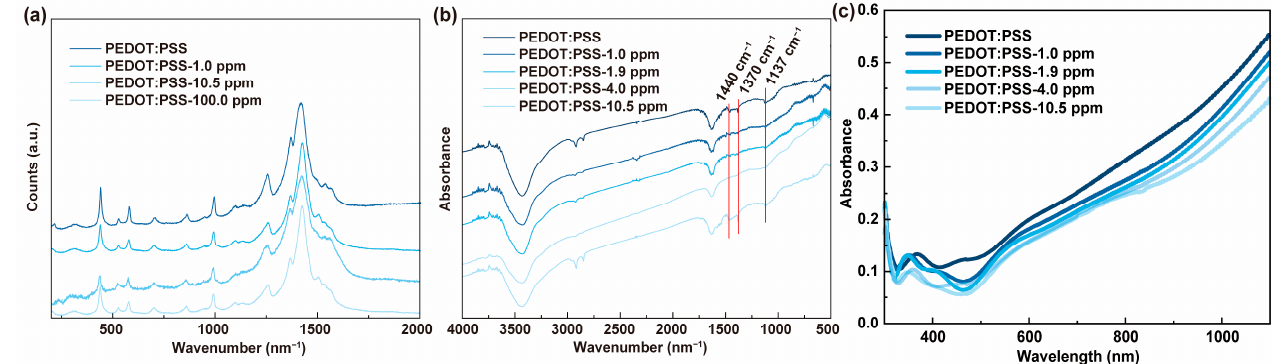
Figure 3. ( a ) Raman spectra, ( b ) Fourier transform infrared spectra, and ( c ) UV–Visible absorption spectra of PEDOT:PSS film before and after exposure to HPV with different concentrations.